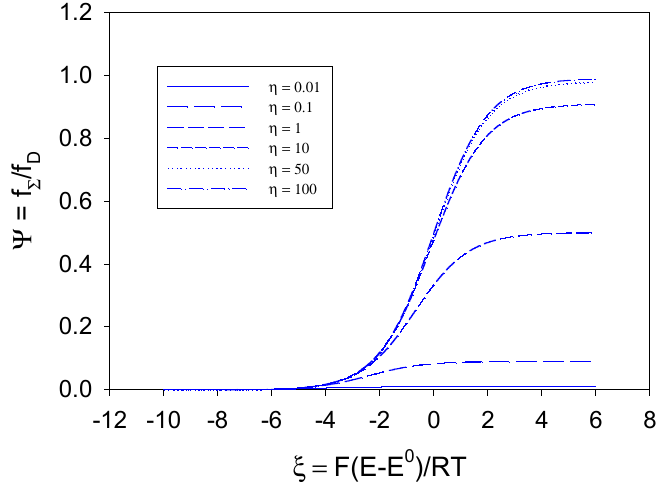
Figure 1. Normalized voltammograms for heterogeneous redox catalysis at an immobilized